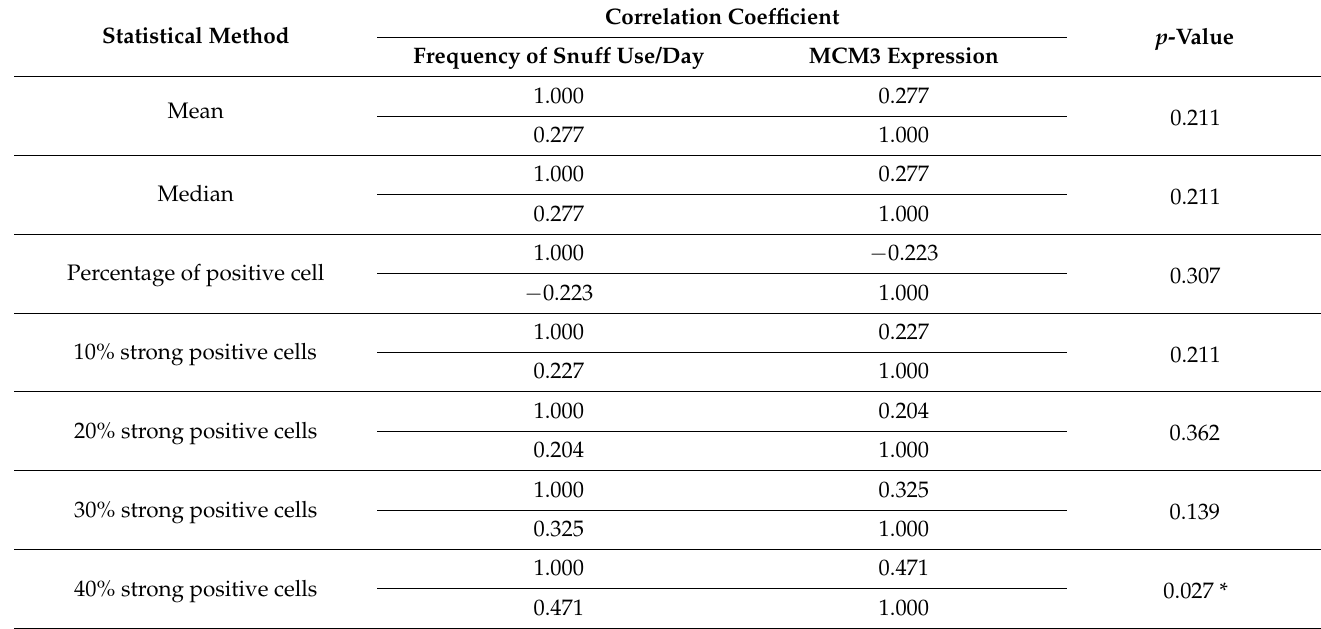
Table 12. Association of frequency of snuff use with MCM3